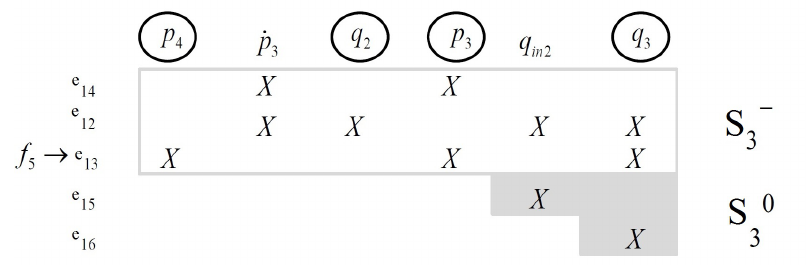
Figure 8. DM decomposition of S 3 .